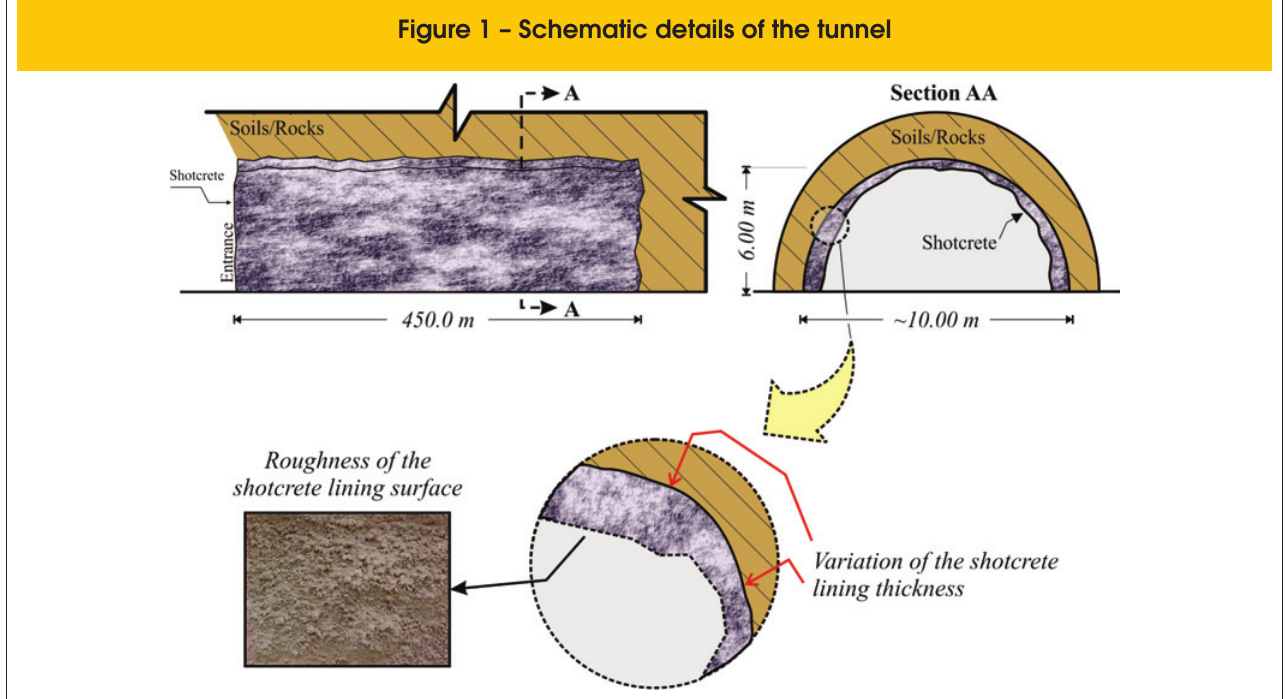
Figure 1 – Schematic details of the